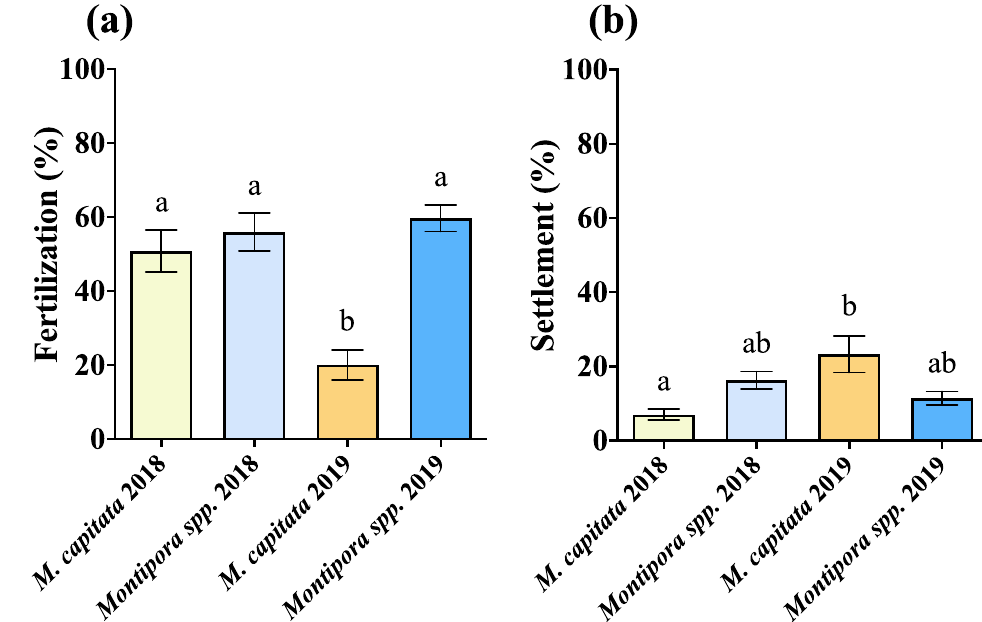
Figure 7. Percent fertilization and percent settlement. ( a ) The difference in mean percent fertilization (2018: n = 14 M . capitata , n = 18 Montipora spp .; 2019: n = 19 M . capitata , n = 30 Montipora spp .; see Table S4 in Supplementary Information for two-way ANOVA results). Fertilization success significantly declined in M. capitata from 2018 to 2019 while remaining consistent in Montipora spp . There was no difference in fertilization success between the two in 2018, but there was a noticeable significant difference in 2019. ( b ) The difference in mean percent settlement between M. capitata and Montipora spp . (2018: n = 36 M . capitata , n = 56 Montipora spp .; 2019: n = 18 M . capitata , n = 55 Montipora spp .; see Table S5 in Supplementary Information for two-way ANOVA results). For M. capitata , there was an increase in settlement percent from 2018 to 2019, but there was no difference between 2018 and 2019 for Montipora spp . Settlement was higher for Montipora spp. than M. capitata in 2018, and this was reversed in 2019. Error bars are SEM, and shared letters above error bars